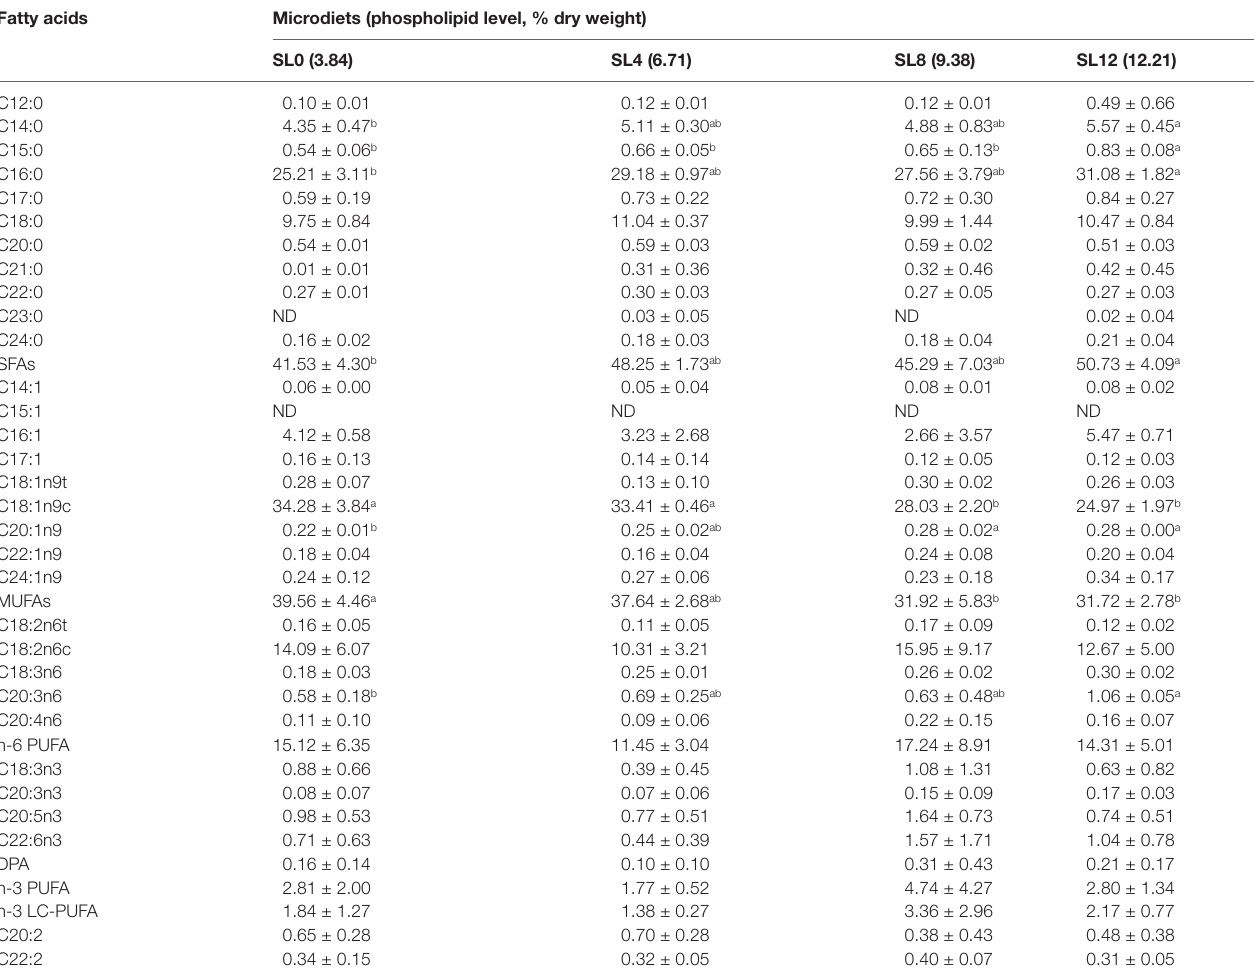
TABLE 5 | Fatty acid composition (%, identified fatty acids) of 55-dph rock bream larvae. Fatty acids